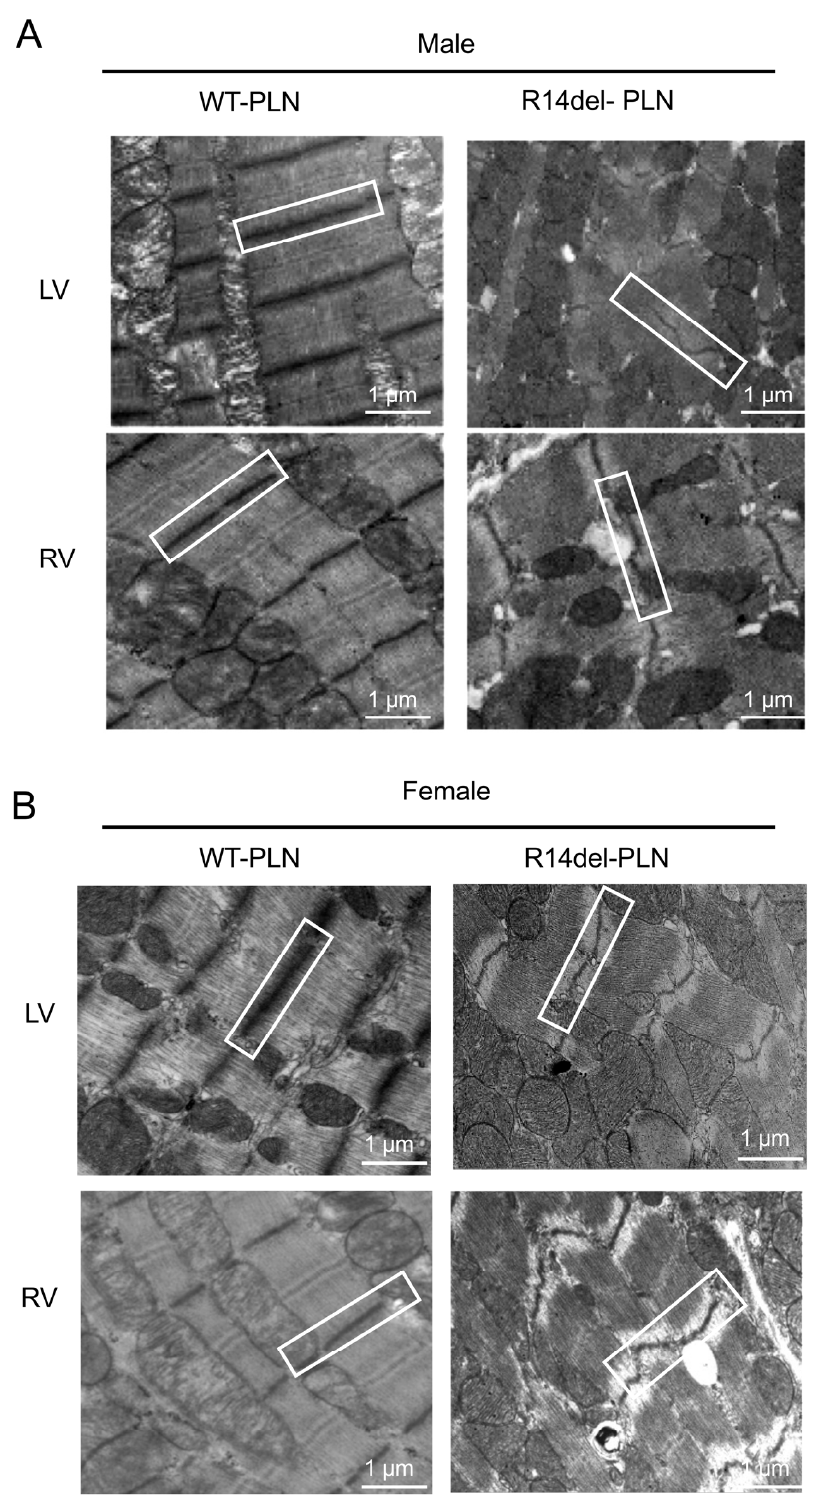
PLN (left panels). Scale bar = 75 µm, 20× magnification views. ( B , D ) Quantitative analysis of ven- tricular fibrosis (expressed as a percentage of total area) in WT- PLN and R14del- PLN hearts (right panel). Data are expressed as mean ± SD for the myocyte fibrosis. n = 5 per group.